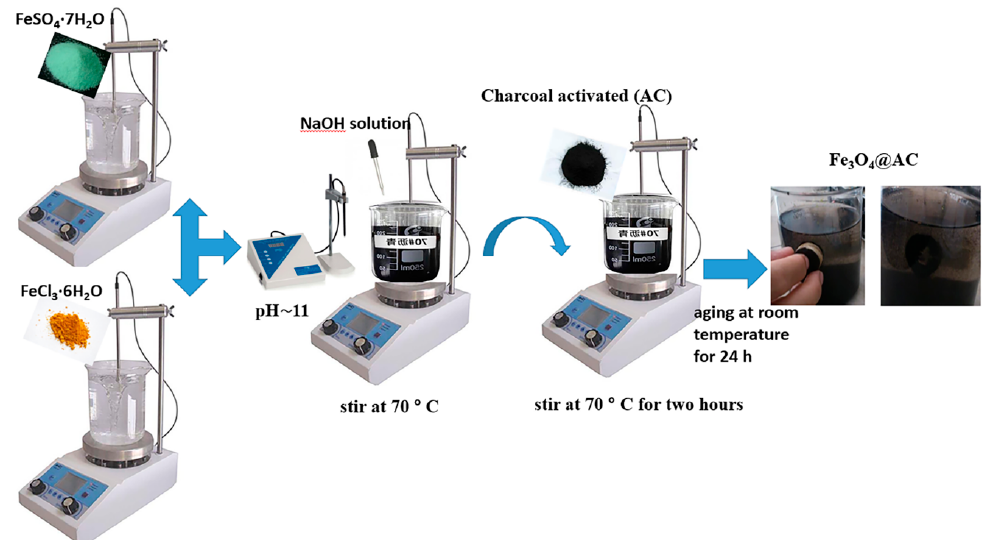
Figure 10. General scheme for the magnetic activated carbon (Fe 3 O 4 @AC) preparation.